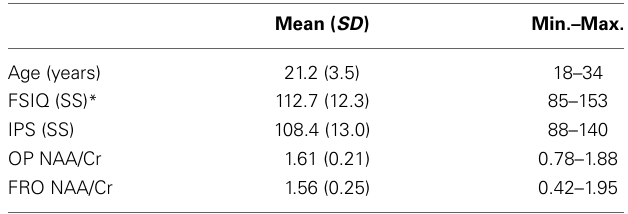
(B) NAA/Cr concentrations in FRO voxels, the bottom two panels show the spectra for minimum (C) and maximum (D) NAA/Cr concentrations in OP